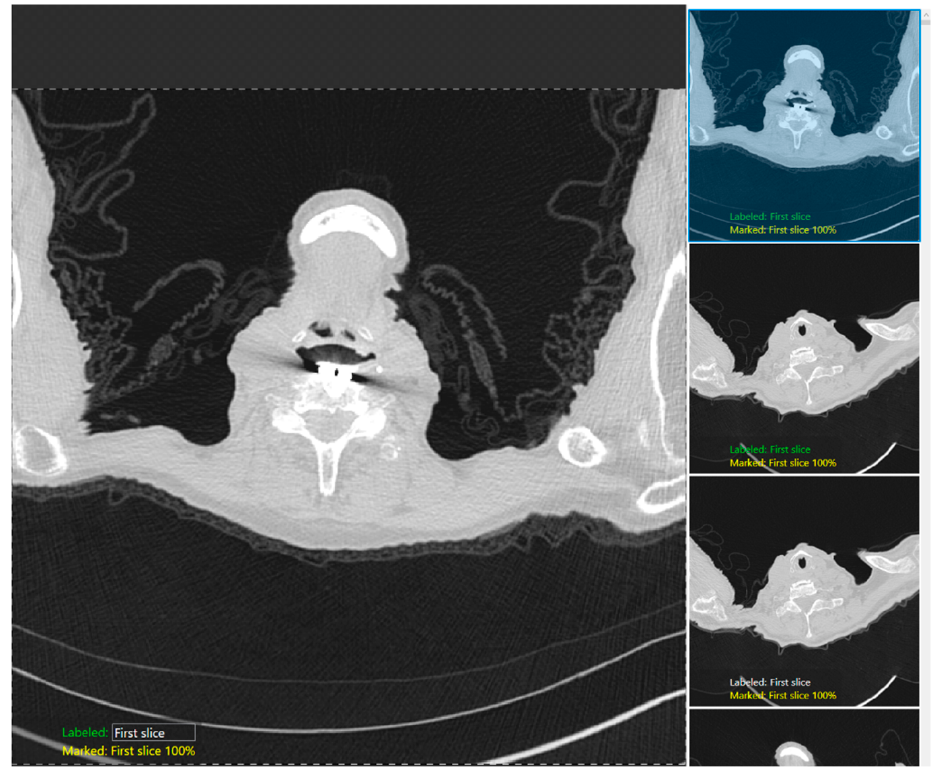
Figure 2. A snapshot of the Green Tool of the DL software used for classification of the anatomic locations at the lung apex.